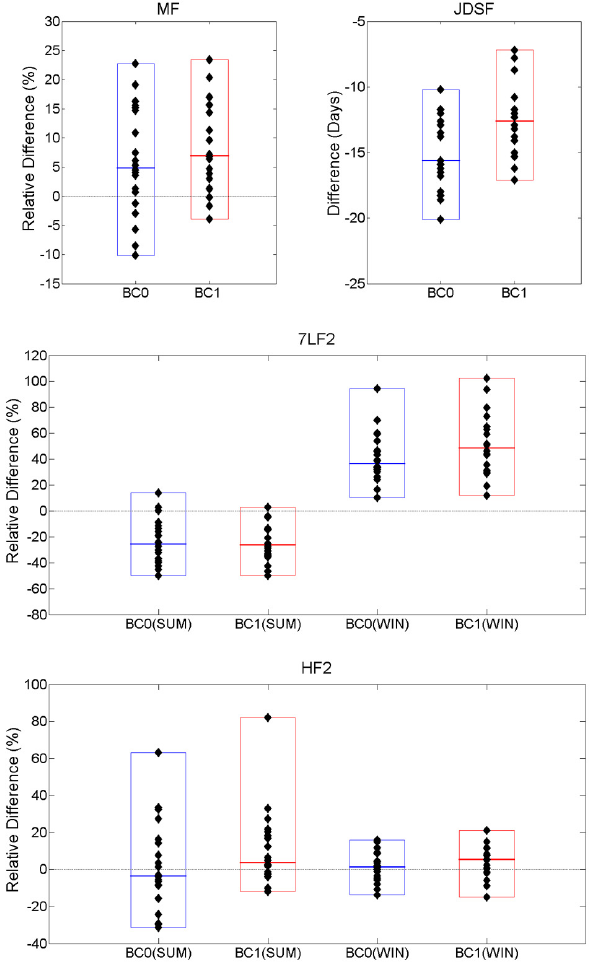
Fig. 8. Relative change of the indicators between reference and fu- ture period at Schlehdorf . The black dots indicate the RACMO sim- ulations driven by ECHAM. Green dots specify RCA simulations driven by different pilots (BCM, ECHAM and HadCM); pink dots indicate the CRCM–CGCM